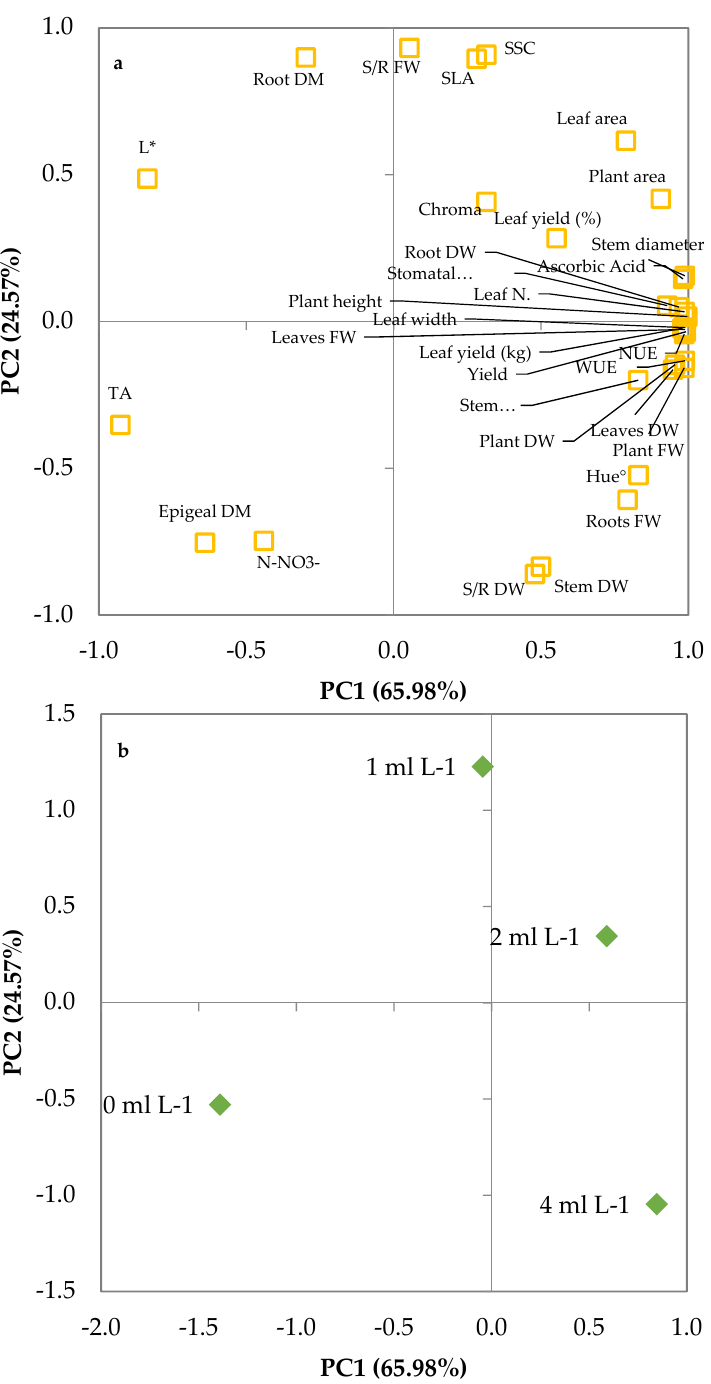
Figure 6. Plot of ( a ) loadings (morpho-physiological and quality characteristics of leaf lettuce plants at harvest) and ( b ) scores (trials) formed by the two principal components from the PCA analysis on leaf lettuce grown on nutrient solutions with 0, 1, 2 and 4 mL L − 1 of Ecklonia maxima extract.